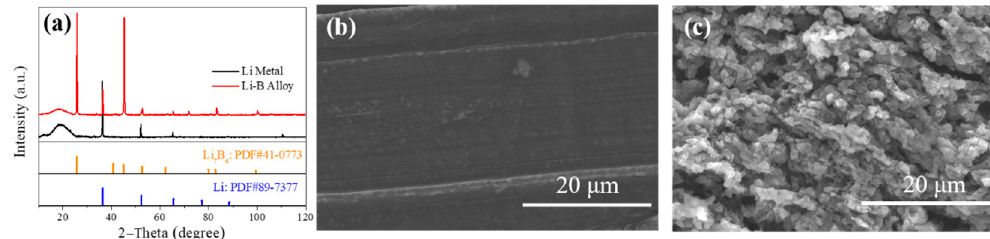
Figure 1. XRD pattern of Li metal and Li-B alloy ( a ); SEM images of Li metal ( b ) and Li-B alloy ( c ).